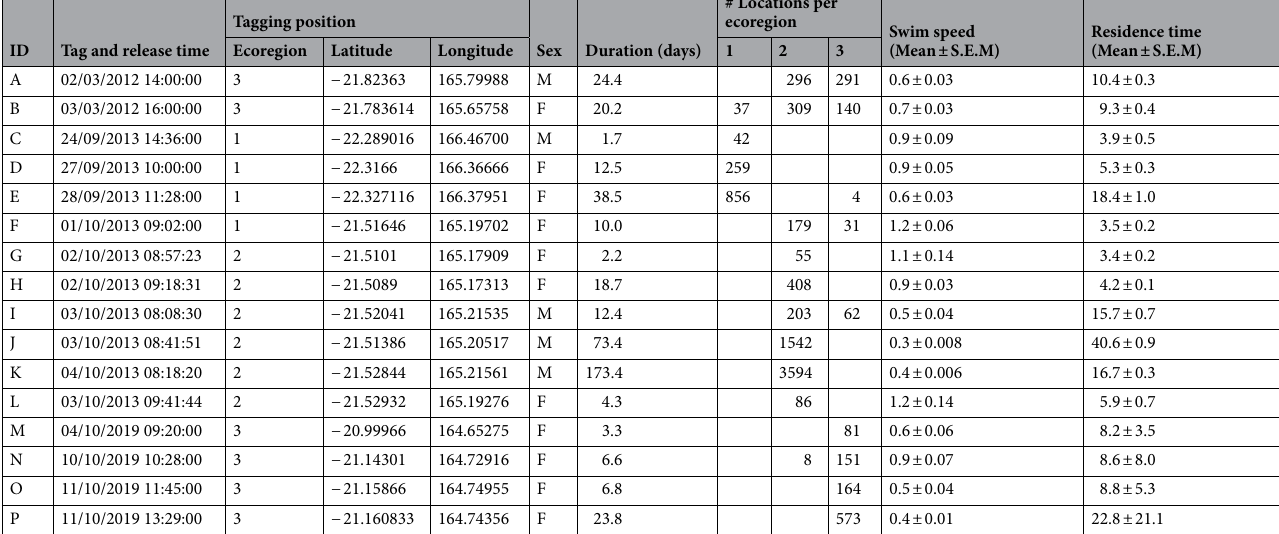
Table 2. Summary of the 16 interpolated dugong GPS tracks recorded in 2012, 2013 and 2019 over the west coast of New Caledonia, South Pacific. ID = individual dugong code, Tag and release time = in local time zone, Tagging position = ecoregion and position in coordinate system EPSG 4326 (latitude and longitude in decimal degrees) where animal was tagged, Sex = M for males and F for females, Duration = duration of the interpolated track in days, # Locations per ecoregion = number of interpolated locations per ecoregion per track, Mean swim speed (km/h) and mean residence time (hrs). Individual tracks are provided in Supplementary Figure